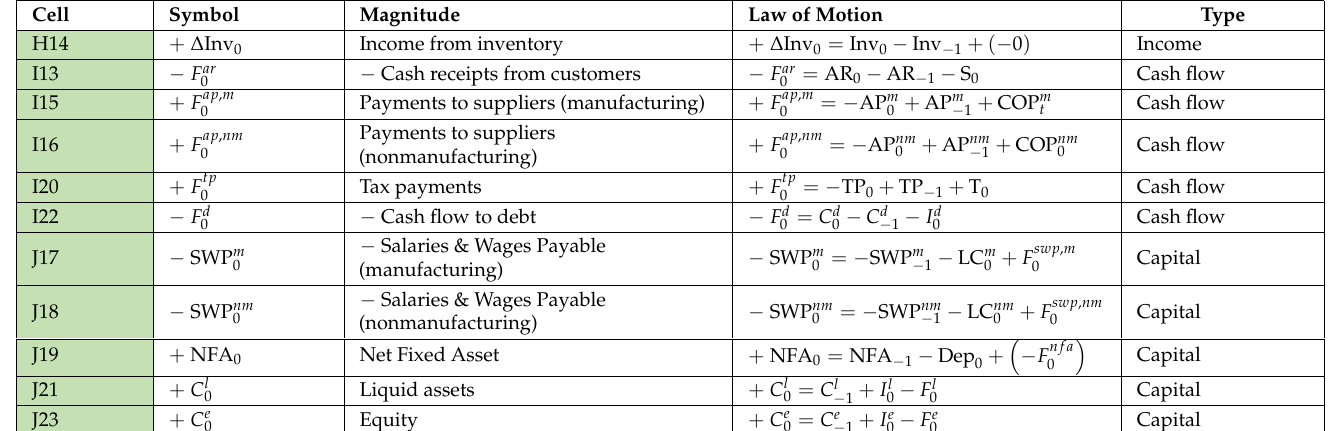
Table 5. Cells whose values are calculated with the law of motion (green